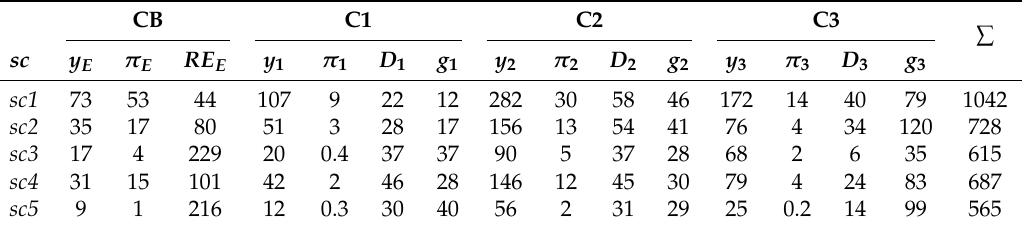
Table 13. Detailed objective function values, robustness experiment ‘exp4’.